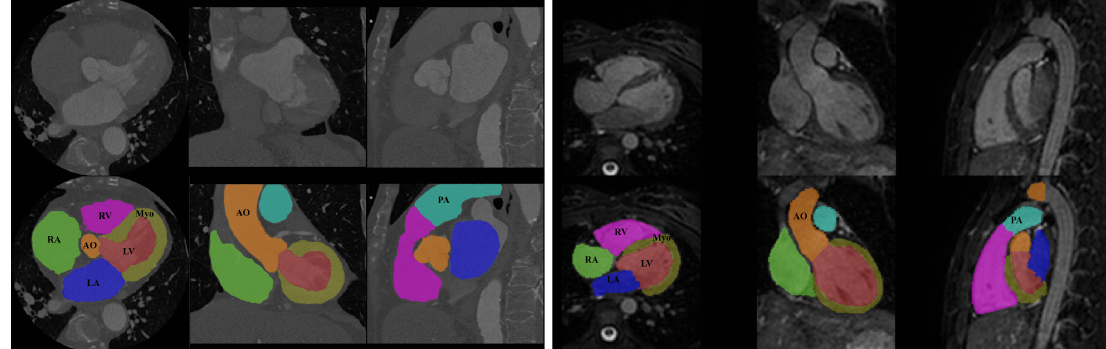
Figure 3. An example of one slice with corresponding ground truth from 3D volume across axial, coronal, and sagittal planes. The ground truths include seven heart structures: LV (red), RV (magenta), LA (blue), RA (green), Myo (yellow), Ao (orange), and PA (cyan).